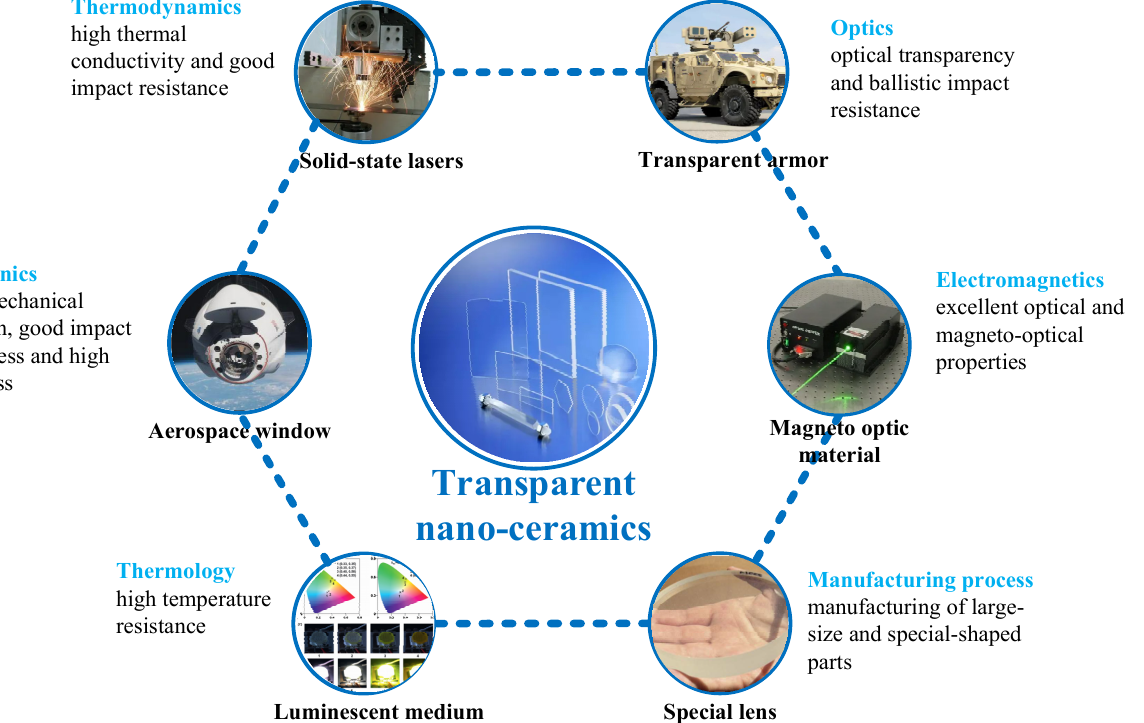
Figure 2. Performance requirements and applications of transparent nano-ceramics.